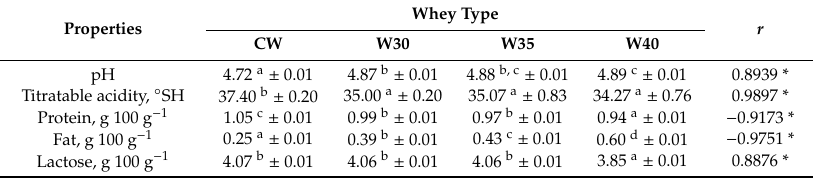
Table 6. Physicochemical properties of goat acid whey.